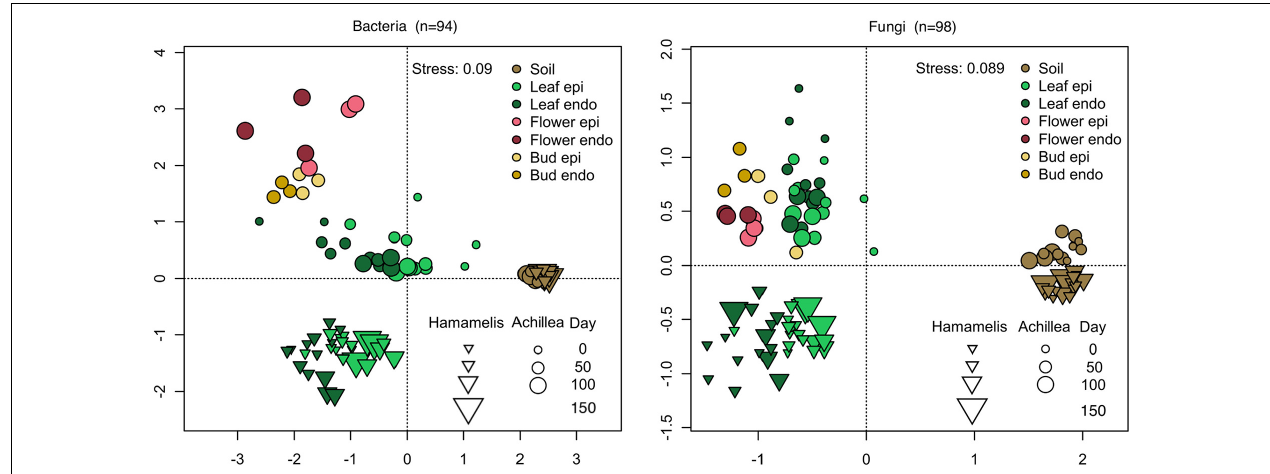
FIGURE 5 | NMDS analysis of bacterial (left) and fungal (right) communities of the time series of Achillea (April to July) and Hamamelis (April to September). Shown are communities of soil, endophytic (endo) and epiphytic (epi) leaf and flower communities in the WALA garden 2016 (location 1a). n : number of samples.